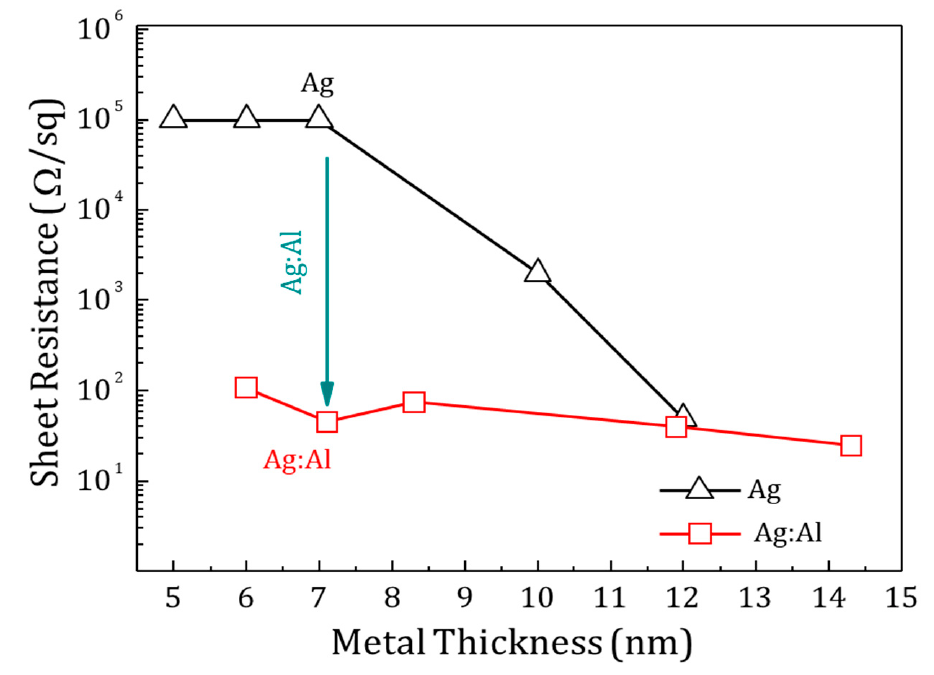
Figure 7. The sheet resistance as a function of thickness for Ag and Ag:Al films are shown. The doping reduces the formation of isolated islands and hence the sheet resistance. The inset compares the resistivity of the Ag and Ag:Al films as a function of thickness.